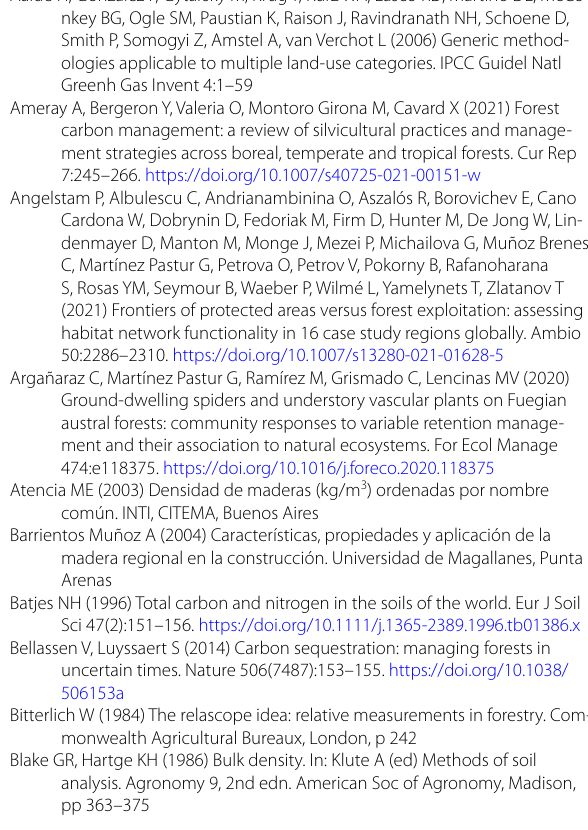
aggregated retention, DR dis‑ = =